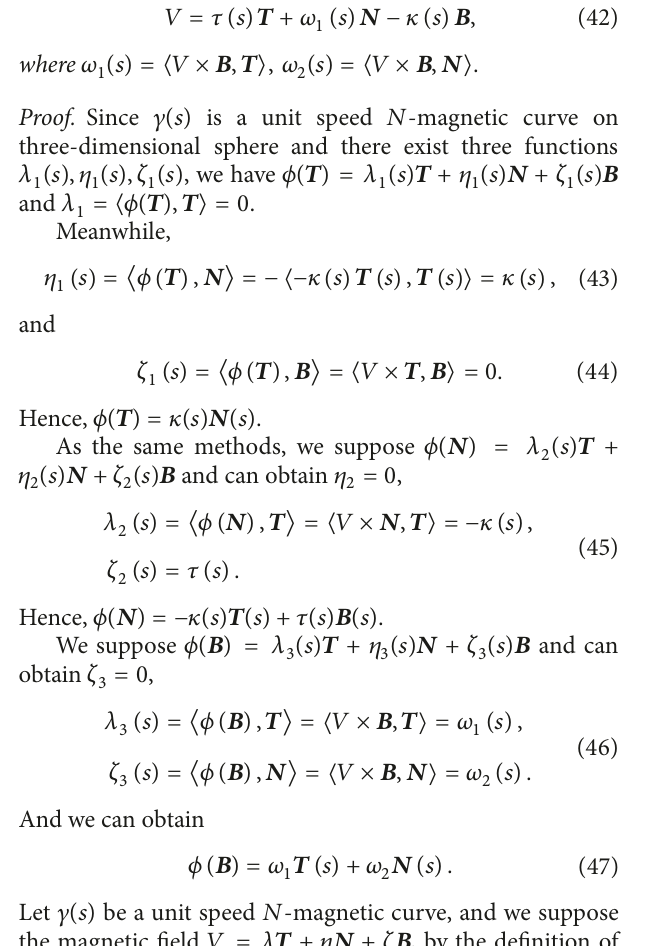
Figure 8: Red vector is 𝑇 , blue vector is 𝑁 , green vector is 𝐵 , and black vector is 𝑉